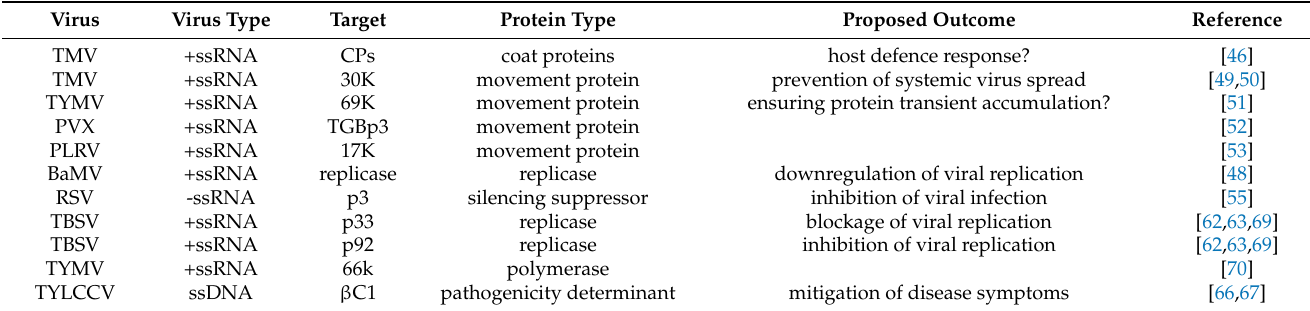
Table 1. Viral proteins targeted by the